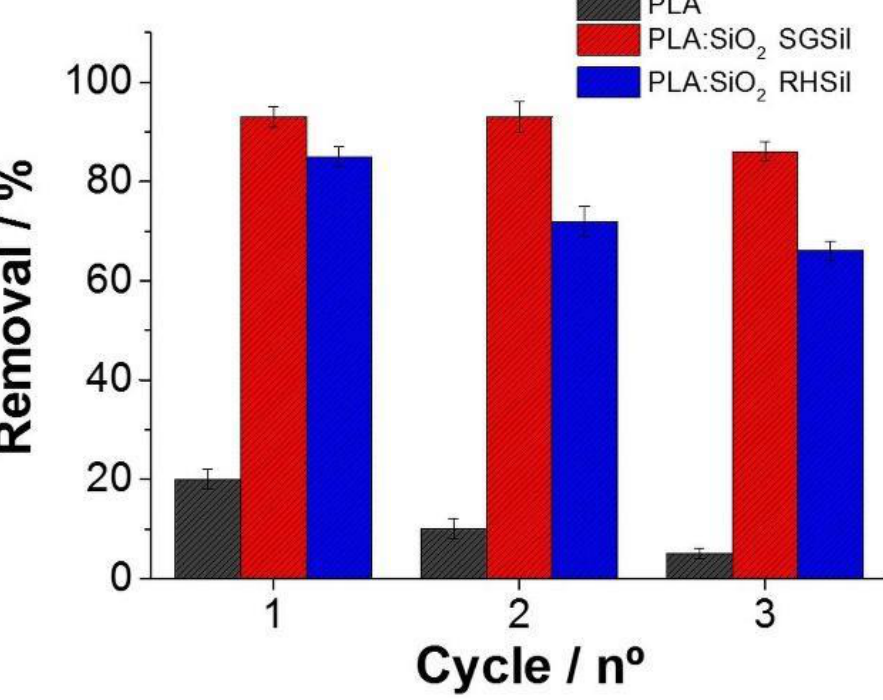
Figure 13. Adsorption cycles for PLA:SiO 2 nanocomposite fibers.